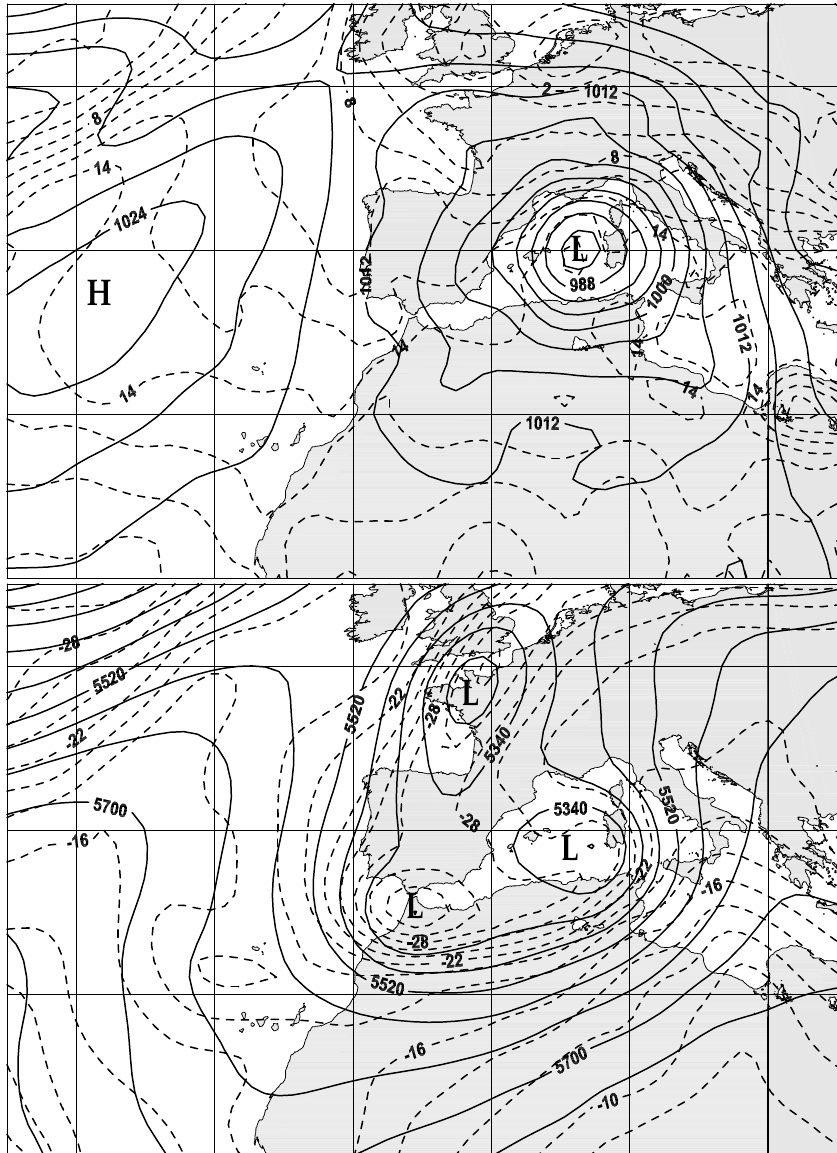
Fig. 8. As in Fig.3, but at 00:00UTC,